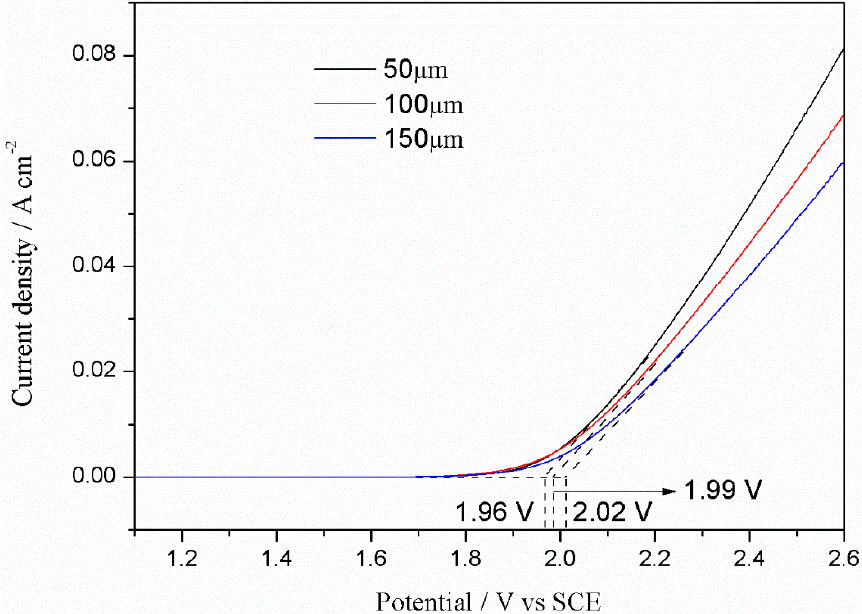
Figure 4. Linear sweep voltammetry (LSV) curves of porous Ti/SnO 2 –Sb 2 O 3 /PbO 2 electrodes in 0.5 mol L − 1 H 2 SO 4 solution at a scan rate of 5 mV·s − 1